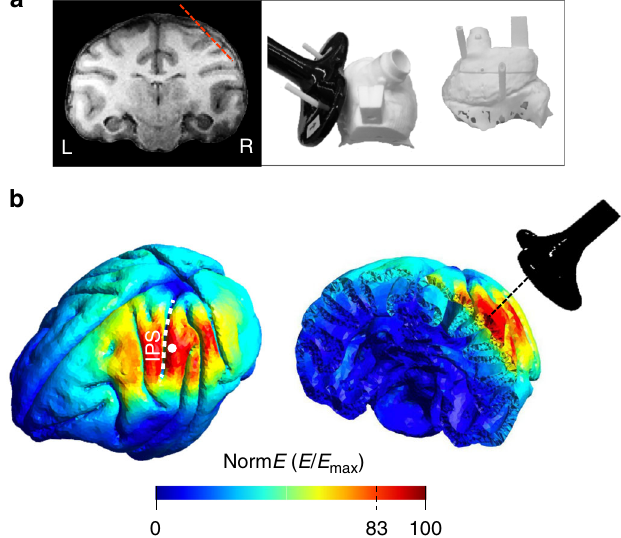
Fig. 1 Brain targeting and model of the spatial spread. a Anatomical magnetic resonance image (left) and 3D models of the monkey ’ s skull (right) indicating respectively, the trajectory of the electrode during recordings (red, dashed line) and the coil positioning method. The right panel shows a top view (left) and a lateral view (right) of a 3D model. During the experiments, a 25 mm fi gure-of-eight TMS coil (black) was rigidly anchored to the monkey ’ s skull to allow precise and reproducible coil positioning across recording sessions. Two guiding rods were attached to the monkey ’ s head implant based on MRI estimations of the cortical target coordinates. b TMS-induced electric fi eld as modelled with simNIBS. Left: rotated model of the brain indicating the normalized electric fi eld distribution (spatial spread) calculated for the D25 coil. The white dot indicates the center of stimulation (center of the coil). Right: Coronal section of the brain across